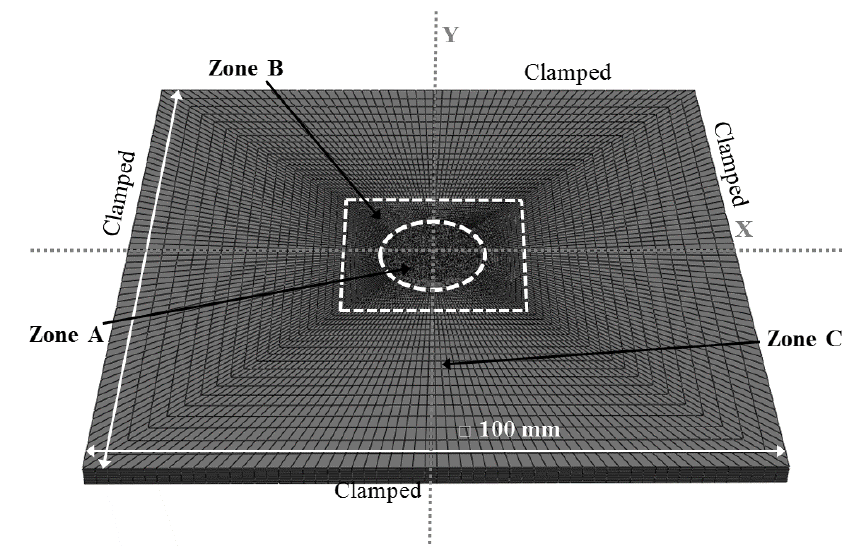
Figure 10. Target mesh used in the numerical simulations.